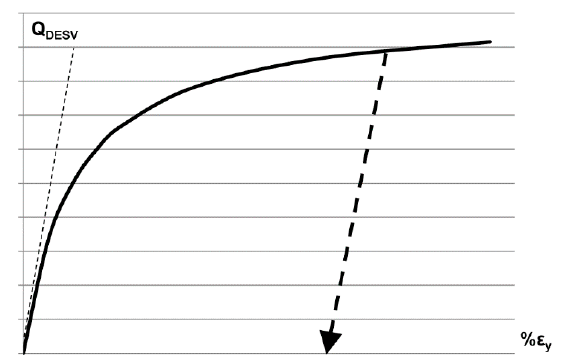
Figure A7. Stress–strain diagram of the loading–unloading process.